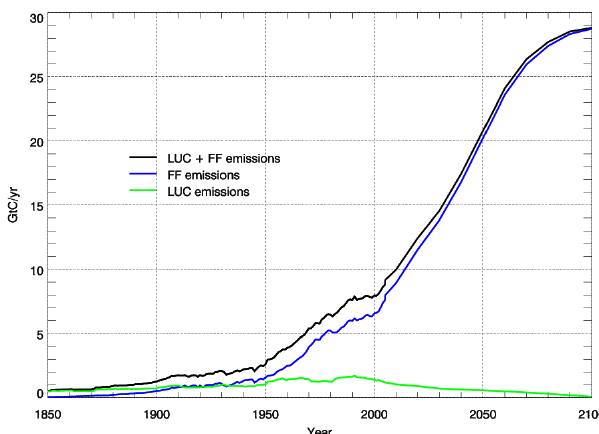
Fig. 3. Global land use emissions data during the transition from the historical simulation to the RCP 8.5 simulation. The Houghton (2008) land use emissions data (black line) were scaled to meet the RCP data (blue line), resulting in the red line with trian- gles, which replaced the black line during 2000–2005.